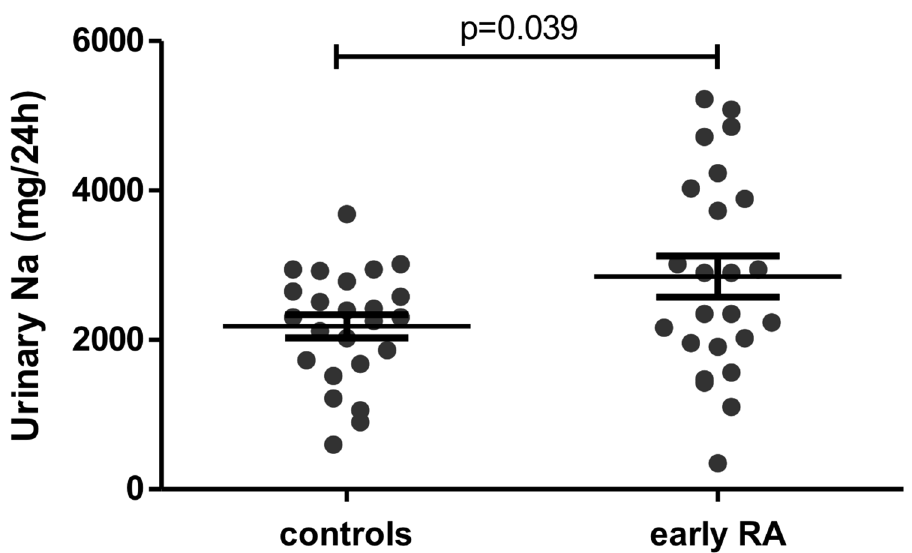
Fig 1. Sodium excretion was higher in patients with early RA than in matched controls. Sodium intake was assessedby 24-hr urinary sodium excretion. Horizontalbars are means and whiskers are SEM. Student t test was used.